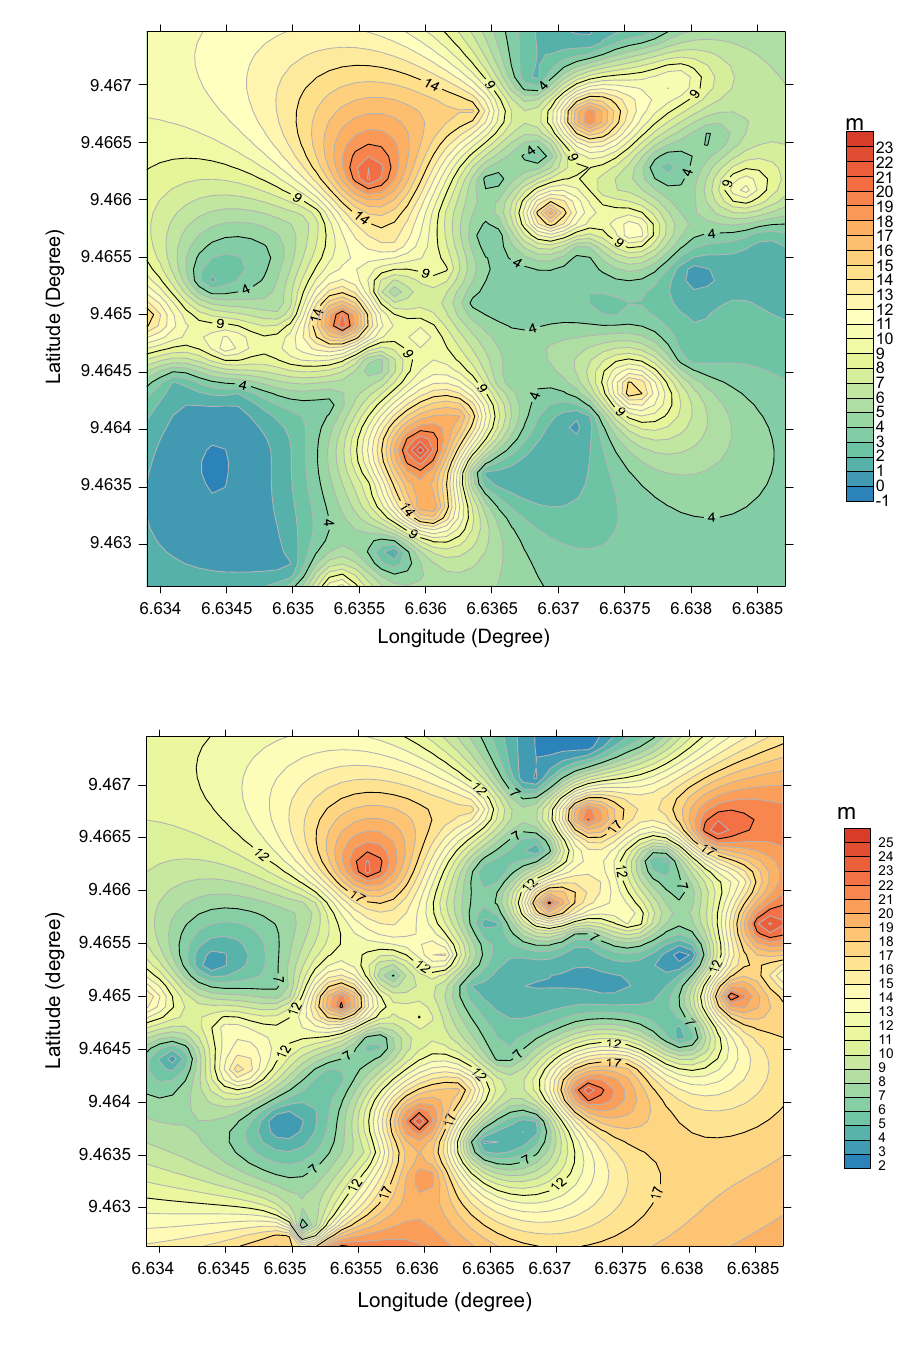
Fig. 8 Isopach map of the weathered layer